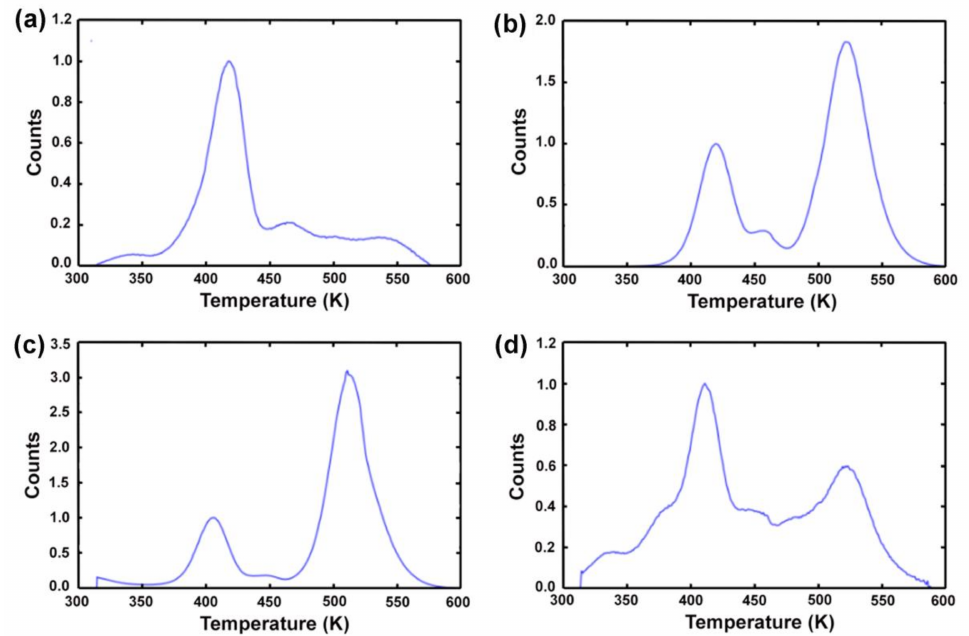
Figure 13. High-temperature thermoluminescence of ( a ) sapphire substrate, ( b ) 650_18 sample, ( c ) 800_50 sample, and ( d ) 1000_50